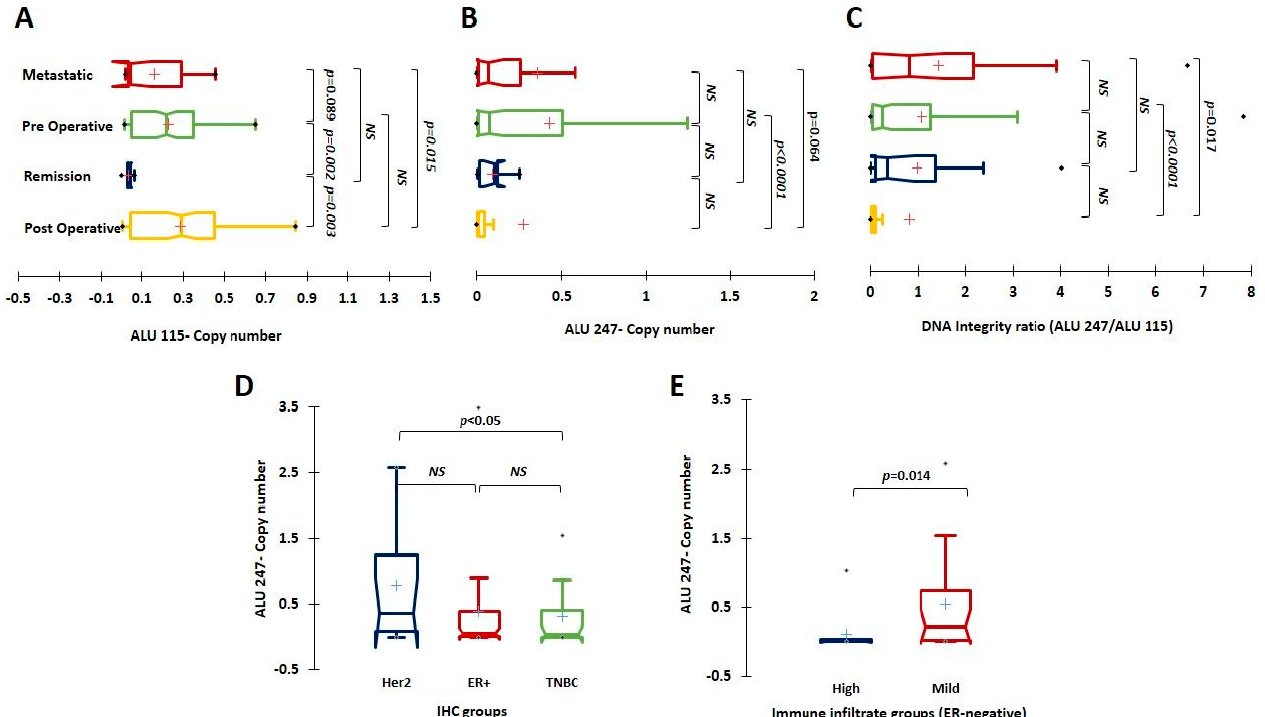
Figure 2. ( A – C ) Univariate analysis depicting levels of ALU 115 and ALU 247 and the DI ratio, respectively, among the metastatic (n = 20), pre-operative (n = 111), remission (n = 12), and post- operative samples (n = 108). ( D ) Comparative analysis of ALU 247 levels among IHC groups Her2 (n = 16), ER+ (n = 57), and TNBC (n = 30) and ( E ) between dense/moderate (n = 16) and mild (n = 23) immune infiltrate groups of the ER-negative subtype. NS : not significant.